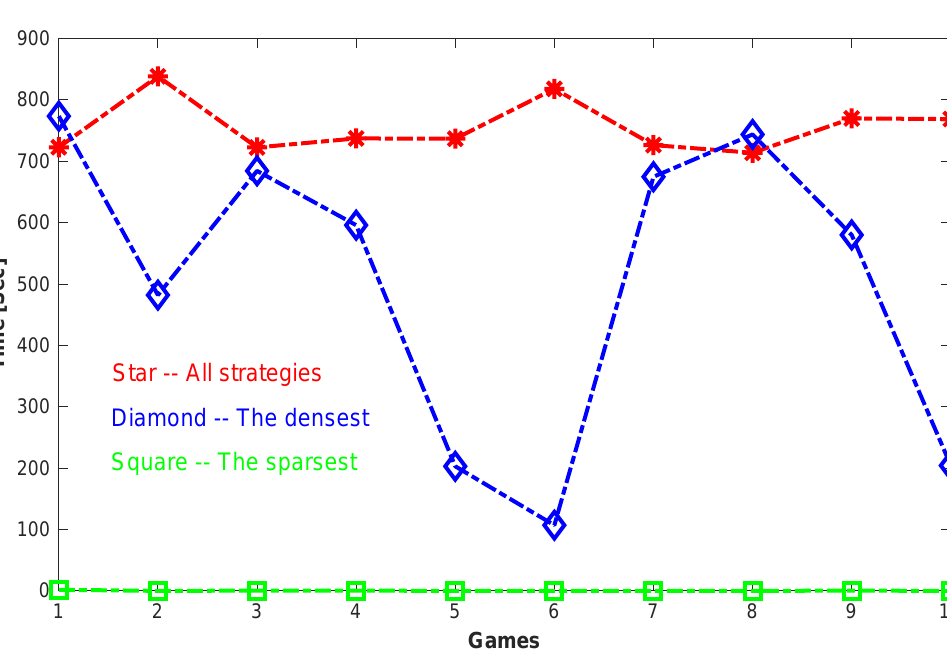
Table legend: Game—Tested 10 games; (cid:107) · (cid:107) 0 —The number of positive components in the densest equilibrium; µ —The average value of positive components; σ —The standard deviation of the positive components; Time—Time in seconds spent to obtain the densest equilibria.